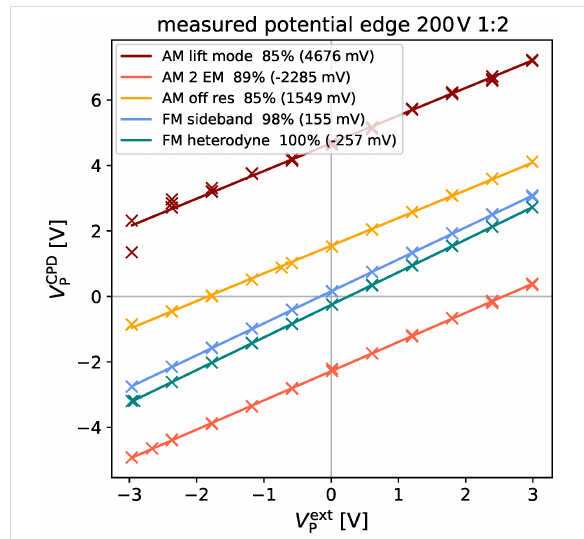
Figure 8: Comparison of the absolute measured potential plotted against the applied potential for AM(warm colors) and FM(cool colors). Legend in the upper left shows the measured CPD at 0 V applied voltage. Data shown captured on the outer most electrodes (1/2) of the electrode structure with an additional electrostatic